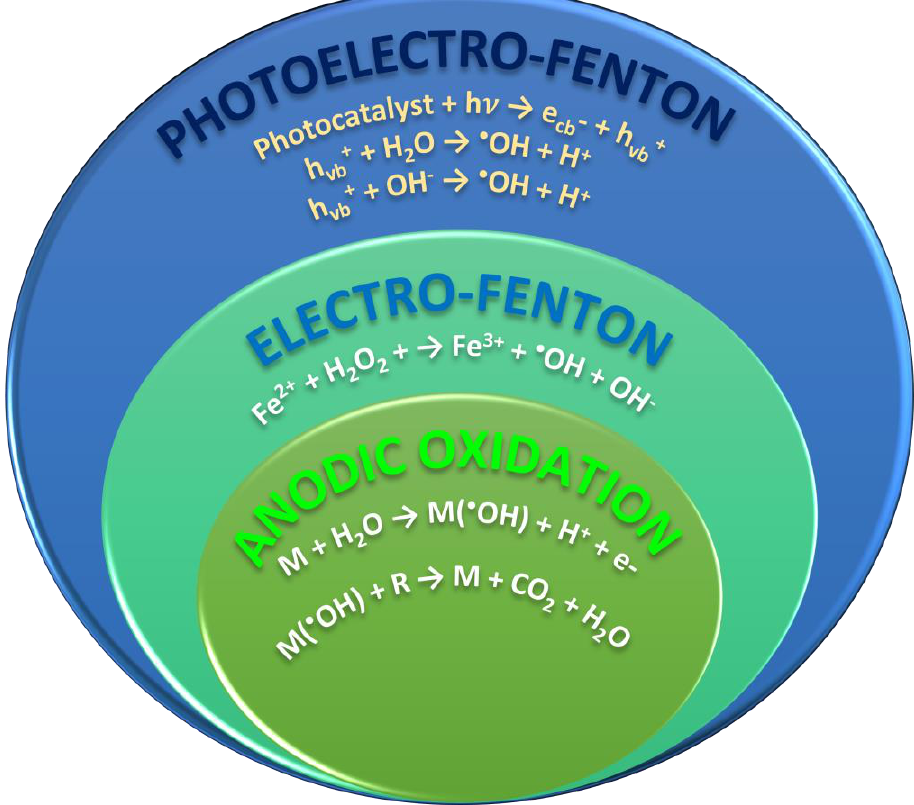
Figure 1. Diagram illustrating the main chemical reactions in EAOPs.